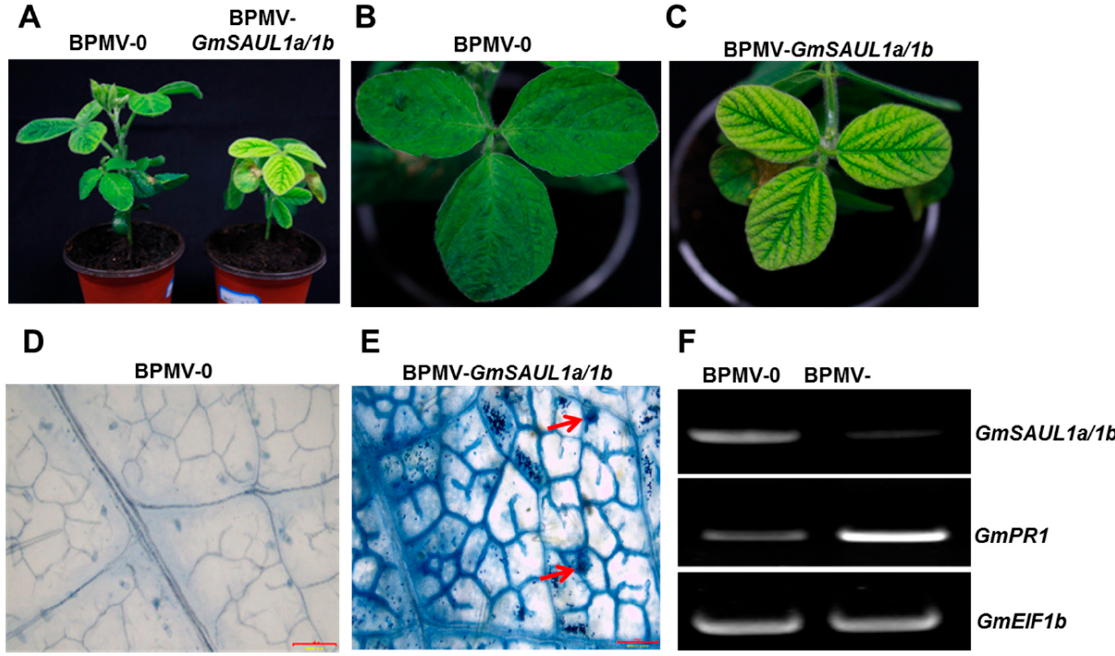
Figure 1. Silencing GmSAUL1a/1b results in activated immune responses in soybean. ( A ) Silencing GmSAUL1a/1b led to stunted stature in soybean; comparison of the leaves of the BPMV-0 plants ( B ) and the leaves of the BPMV- GmSAUL1a/1b plants ( C ). Cell death was observed on the leaves of the BPMV- GmSAUL1a/1b plants, but not on the leaves of the BPMV-0 plants. ( D ) BPMV-0 leaf stained with Trypan blue. ( E ) BPMV- GmSAUL1a/1b leaf stained with Trypan blue. The dead cells are pointed out by the red arrows. ( F ) RT-PCR analysis showing that the GmSAUL1a/1b transcript was signi fi cantly silenced in the GmSAUL1a/1b -silenced plants relative to the BPMV-0 plants and the expression of the GmPR1 was signi fi cantly induced in the GmSAUL1a/1b -silenced plants relative to the BPMV-0 plants. Bars = 0.5 mm.